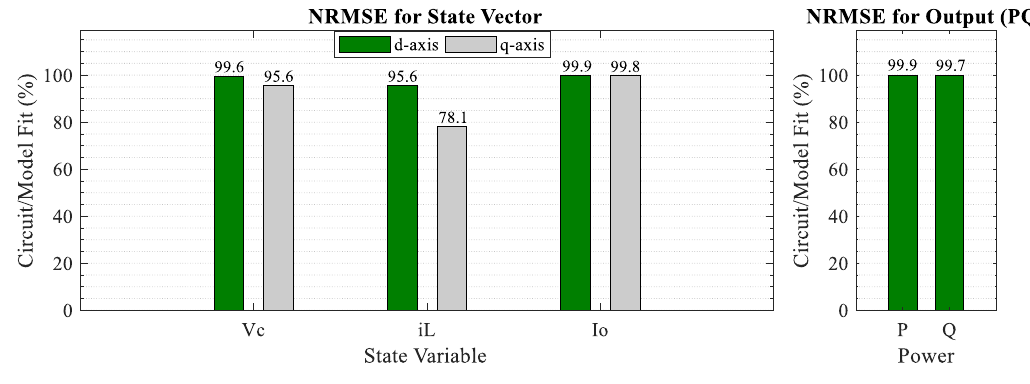
Figure 7. State-vector waveforms for the mathematical model and the circuit in grid-connected mode. ( a ) dq frame. ( b ) ABC frame.